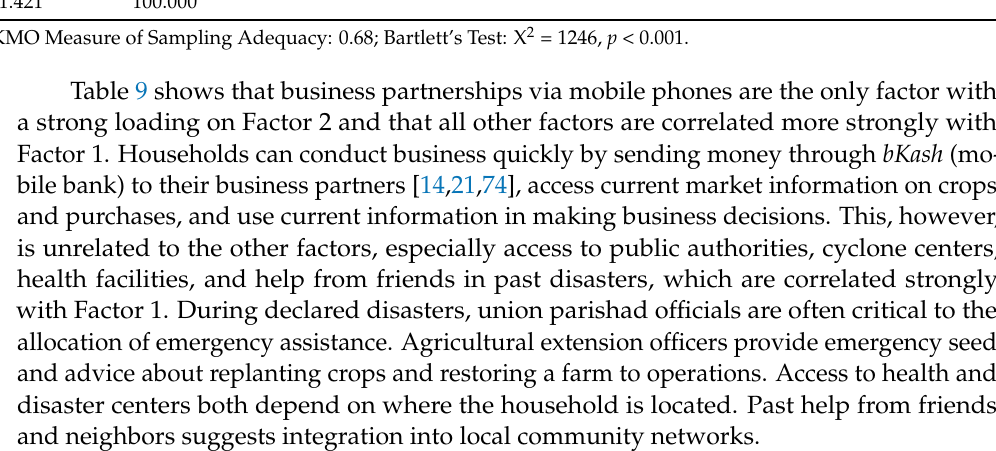
Table 9. Factor loadings on SSN.